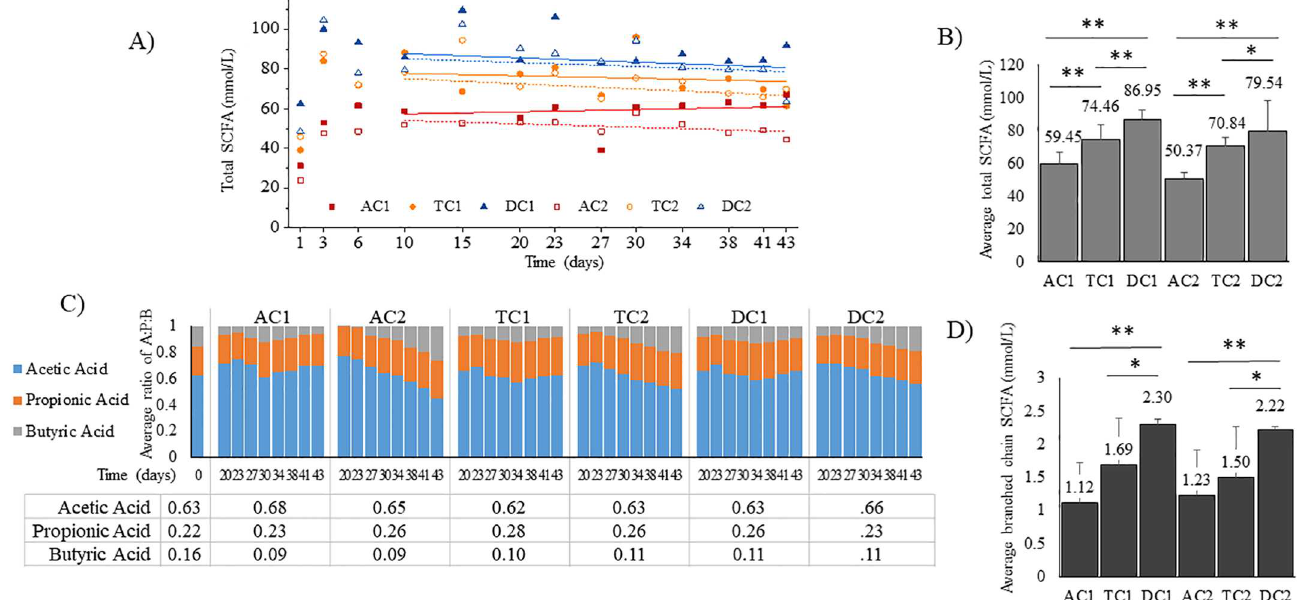
Fig 8. SCFA analysis for the TWINSHIME system. (A) Total SCFAs measured for each region over time (mmol/L). (B) Total average amount of SCFAs (mmol/ L) and (C) Ratio of Acetic Acid: Propionic Acid Butyric Acid for each region over time. (D) Total average branched chain SCFAs (mmol/L) for each region after system stabilization (Day 17–43). The bar marked 0 is the amount of A:P:B for the original fecal inoculum. In the table underneath is the average ratio numbers for A:P:B for each region. A (cid:3) indicates p < .05 and (cid:3)(cid:3) indicates p < .003 according to a 2-tailed student t